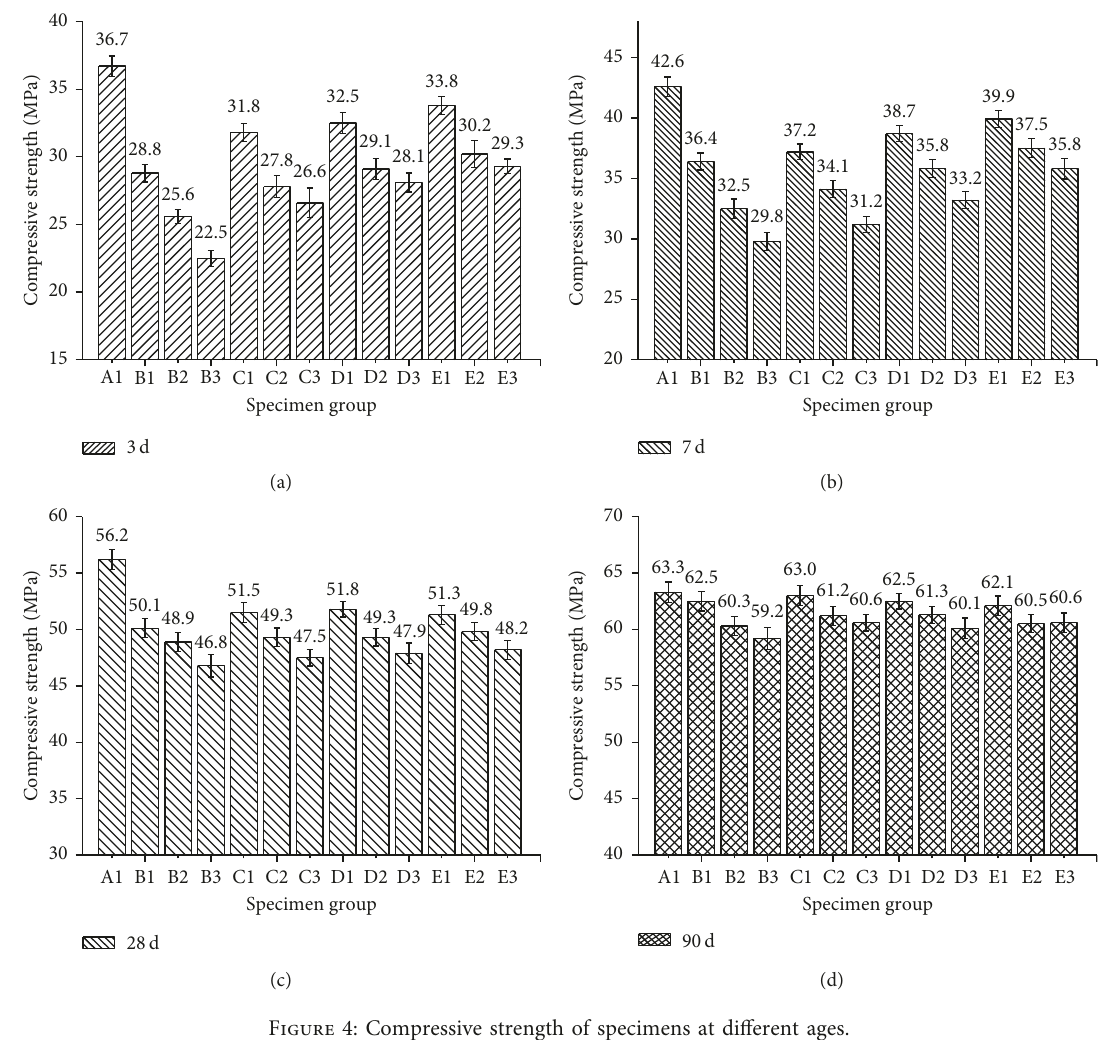
Figure 4: Compressive strength of specimens at different ages.